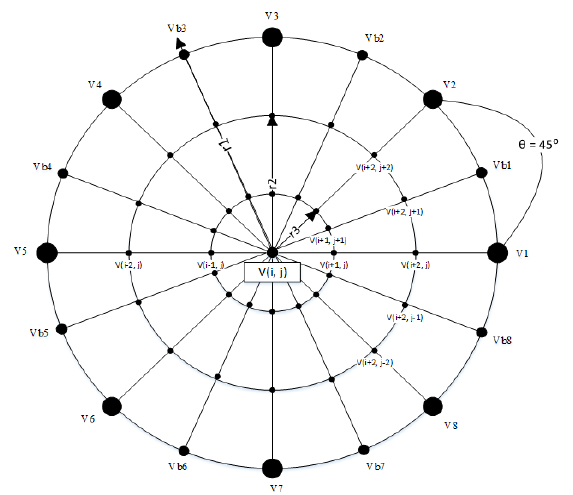
Fig. 3: A circular test tank of radius r 1 . The radii of the two concentric circles are r 2 and r 3 . Voltages V 1 -V 8 are the measured electrode voltages. The electrodes are separated by an angle of θ=45 degrees. V b1 -V b8 are the voltages obtained from bi-curvi- linear interpolation of V 1 -V 8 . The voltages V (i, j)’ s are the nodal voltages, which are derived from Gauss-Seidel